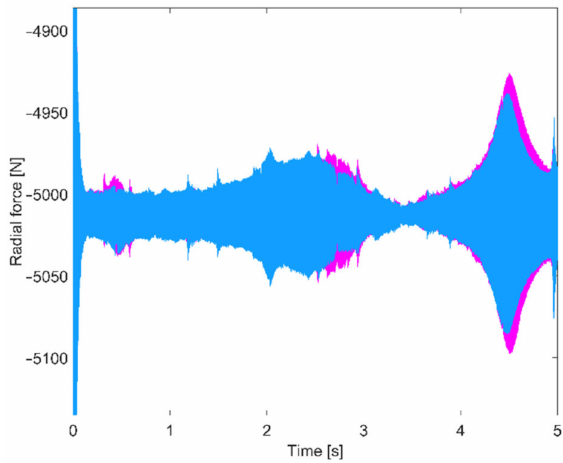
Figure 8. Dynamic variation in the radial force for the two different geometries on B 1,1 (blue—solid web, purple—flexible web).